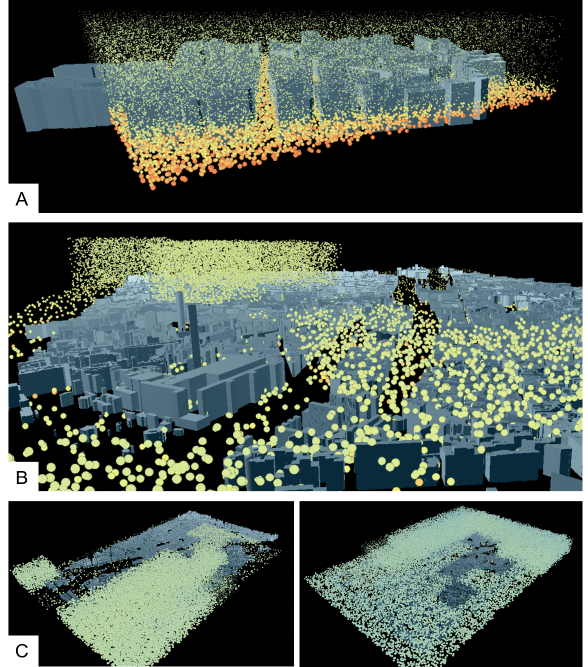
Figure 9. Exploration of different ways to highlight extreme values and spatial gradients in the temperature 3D distribution; (A) using high points size and density to represent the high values of temperature; (B) using filtering to hide the lowest values of temperature; (C) using animation to display the different temperature value intervals one after the